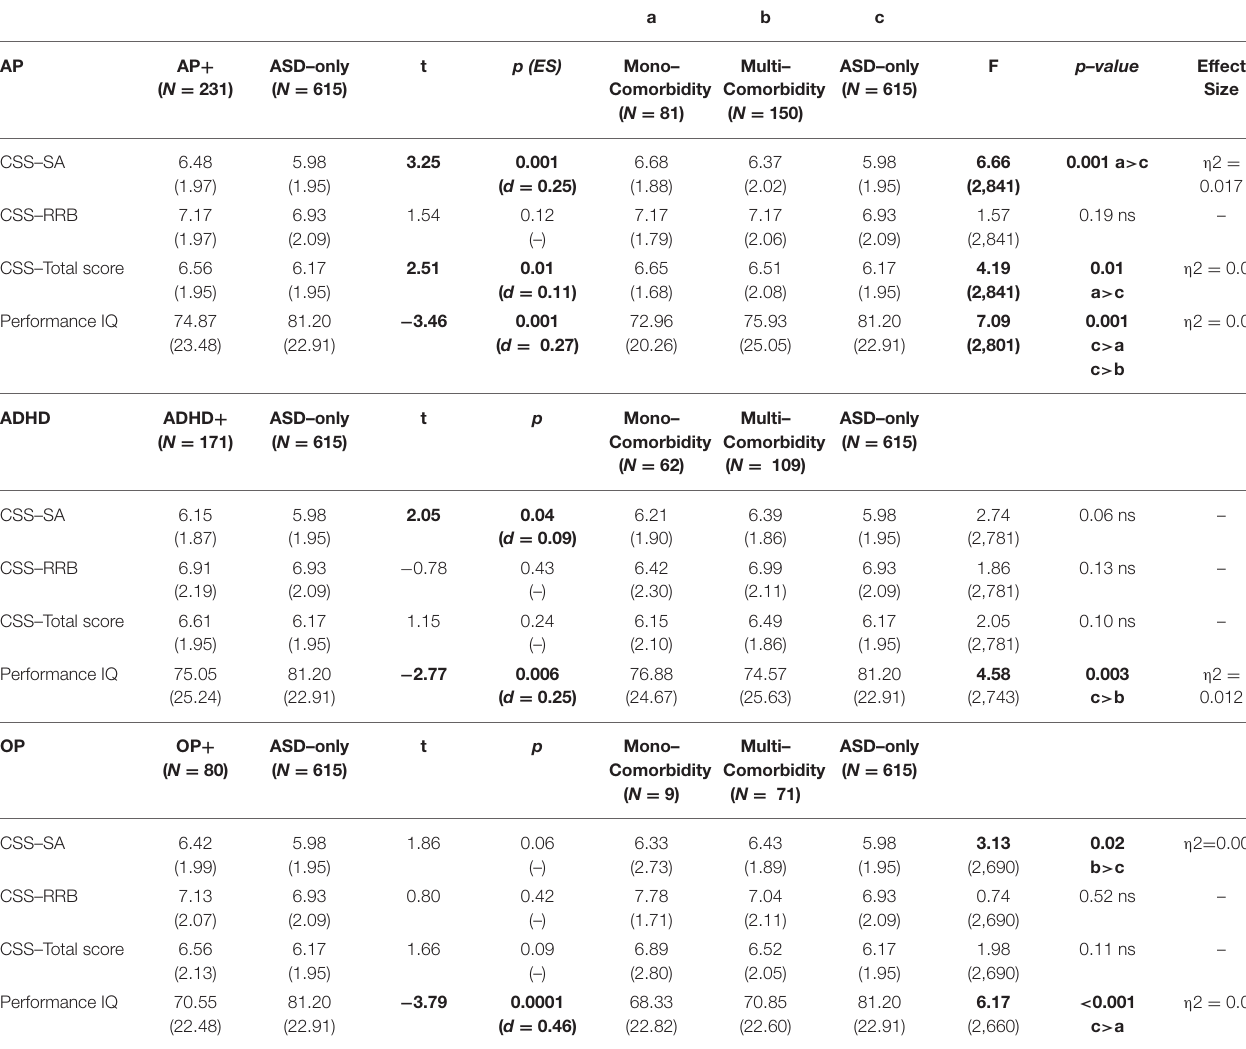
TABLE 3 | Clinical characteristics of ASD subjects grouped on the base of specific PC.